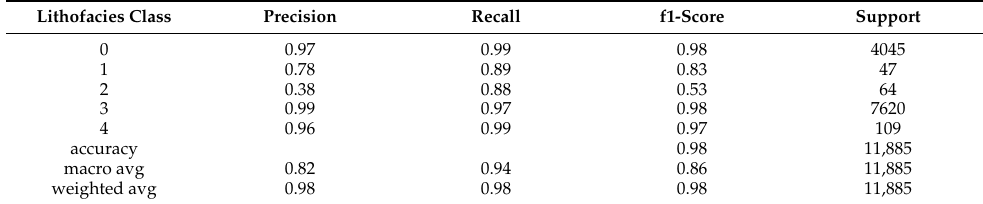
Table 9. Classification report of RFC for Kazakhstan field test